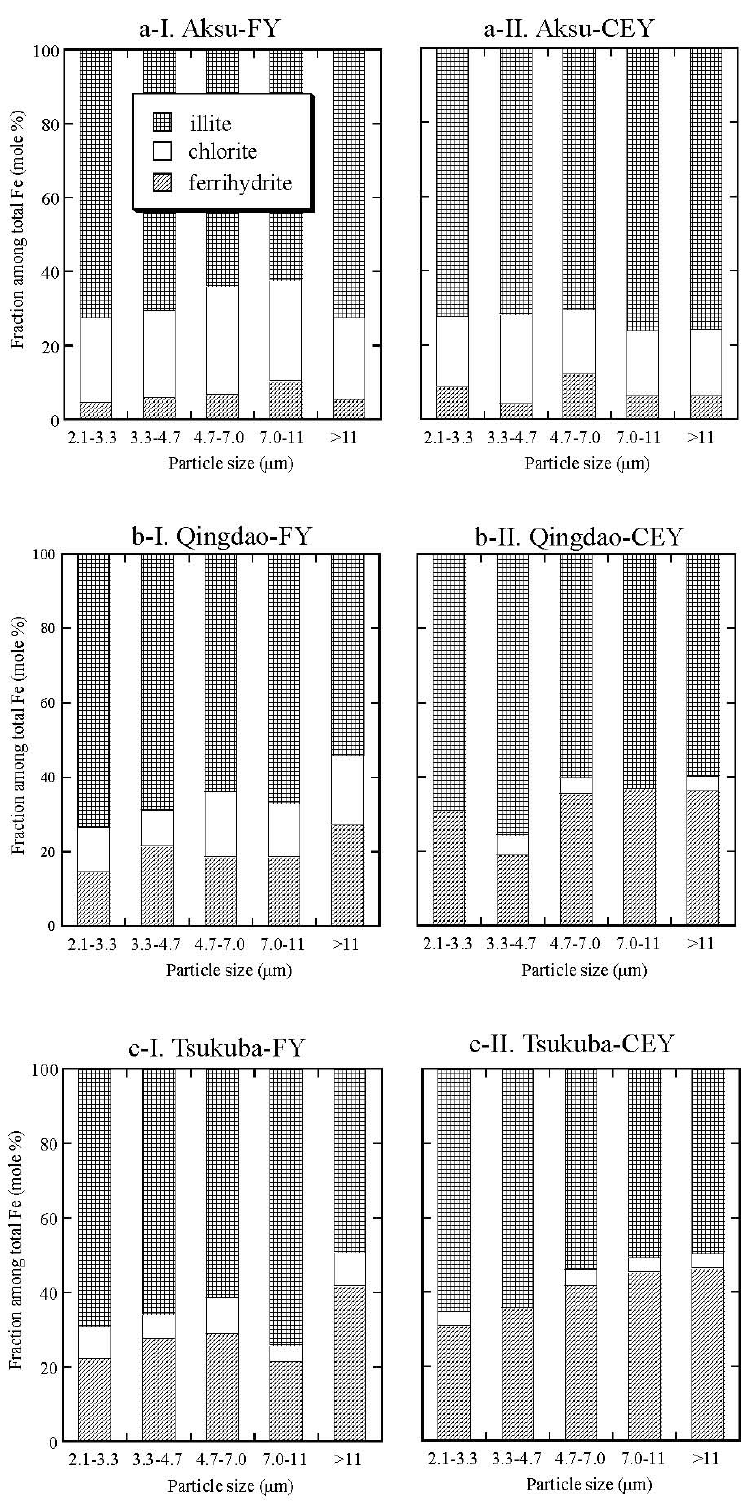
Fig. 9. Fraction of Fe species among total Fe at various particle sizes. (a) – (c) LCF results obtained in FY- and CEY-XANES in Aksu, Qingdao, and Tsukuba,